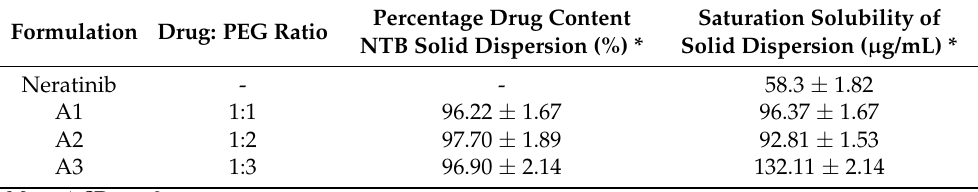
Table 3. Percentage drug content and saturation solubility of NTB PEG solid dispersion. Formulation Drug: PEG Ratio